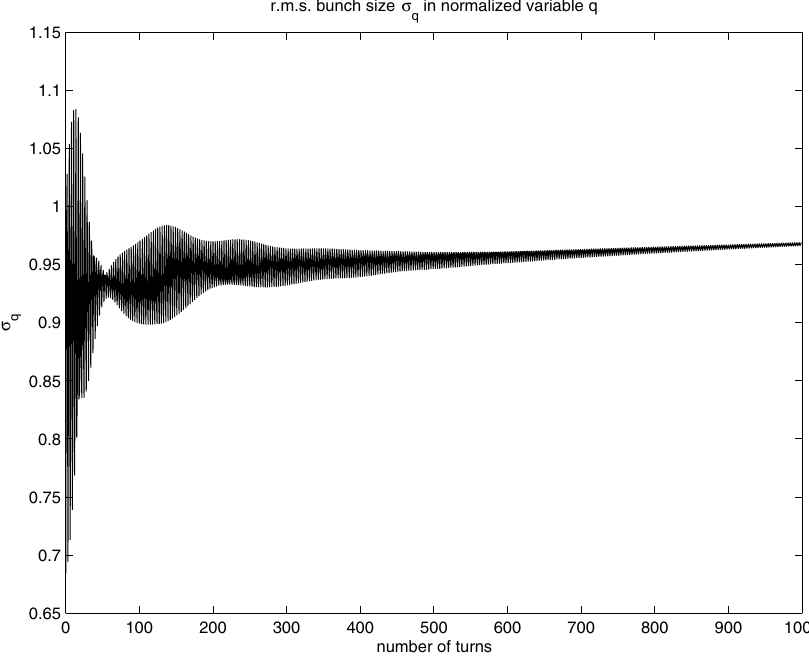
FIG. 1. Bunch size !